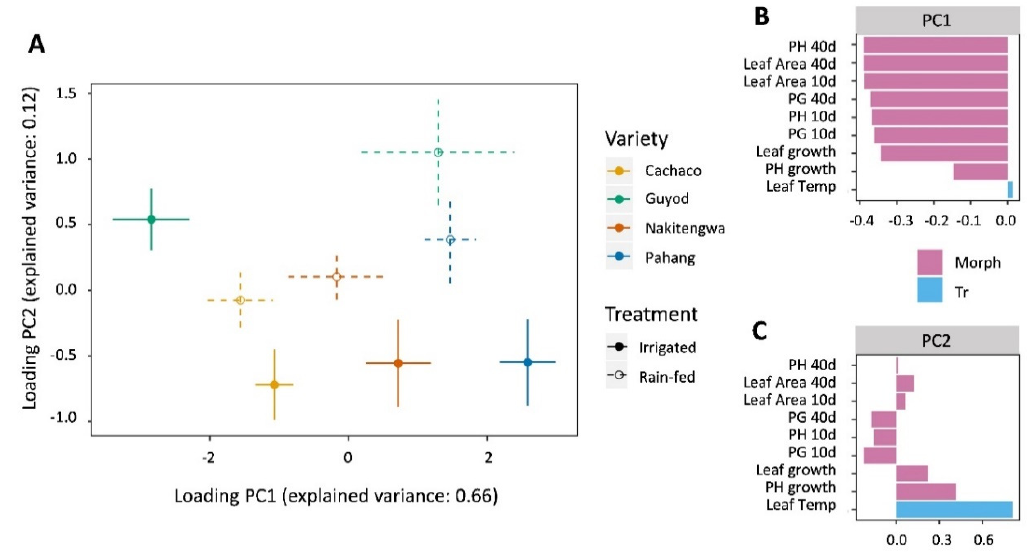
Figure 4. ( A ). Principle component analysis (PCA) of the early plant growth parameters and mean leaf temperature recorded during the vegetative phase of cycle 1 for the four selected Musa genotypes in irrigated vs. rain-fed treatments. Dots indicate mean scores over PC1 and PC2 for each genotype and treatment combination. Bars indicate standard error of the mean. ( B ). Contribution of each measured parameter to the first principal component (PC1); ( C ). Contribution of each measured parameter to the second principal component (PC2). Morph (pink): morphological variable; Tr (blue): temperature variable; PH: pseudostem height; PG: pseudostem girth; d: days after stopping irrigation; Temp: temperature.